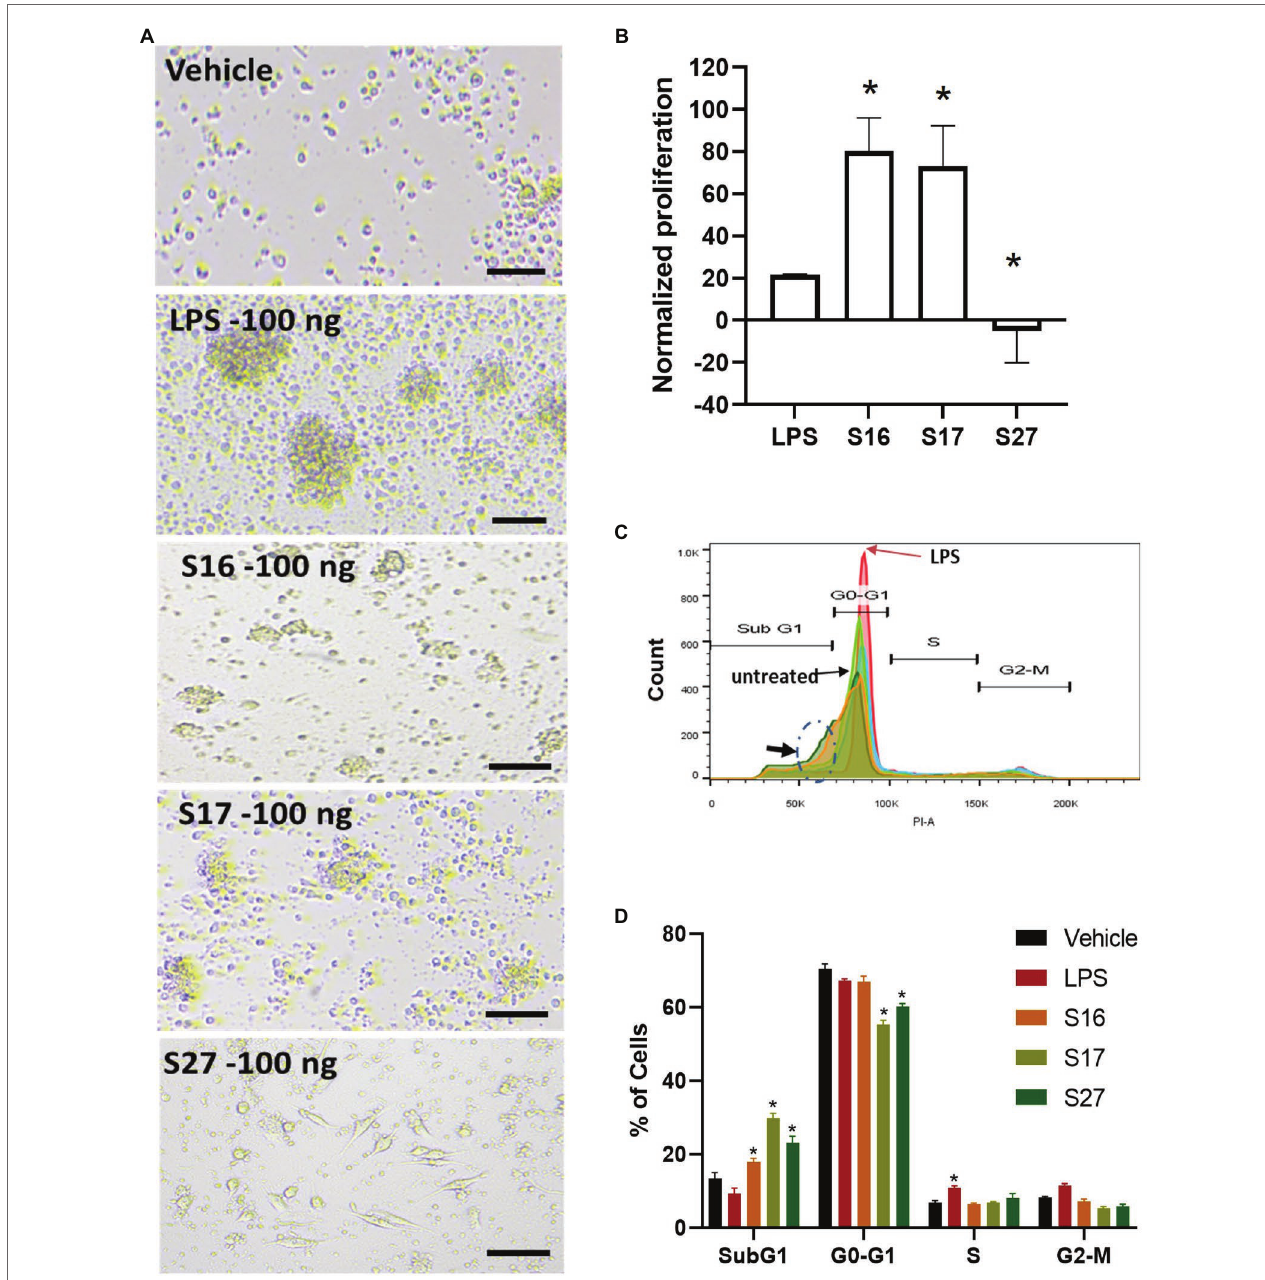
FIGURE 5 | PBMM response to S16, S17, and S27 peptides. (A) Changes in the morphology of macrophages in response to peptides. Scale bar = 100 um. (B) XTT proliferation assay. The results were analyzed using one-way ANOVA and presented as mean ± SEM. * p < 0.05, considered as significantly different from other groups. (C) Flow cytometry histogram indicating the shift in cells population from G1 phase to sub G0 phase (dashed circle marked with arrow). (D) Cell cycle analysis of macrophages incubated with the peptides. The results were analyzed using two-way ANOVA and presented as means ± SEM of three independent experiments. * p < 0.05, considered as significantly different from other